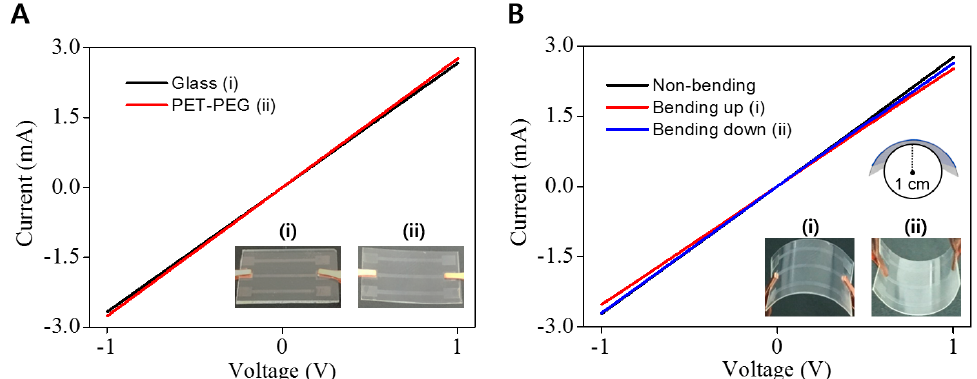
Figure 4. ( A ) Current–voltage (I–V) characteristics of AgNW-PEG line patterns (i) on glass before the direct transfer process, and (ii) on PET substrate after direct transfer (0.6 wt % AgNW concentration). ( B ) I–V curves of AgNW-PEG line patterns on PET during a bending test (0.6 wt % AgNW concentration; 1 cm bending radius).